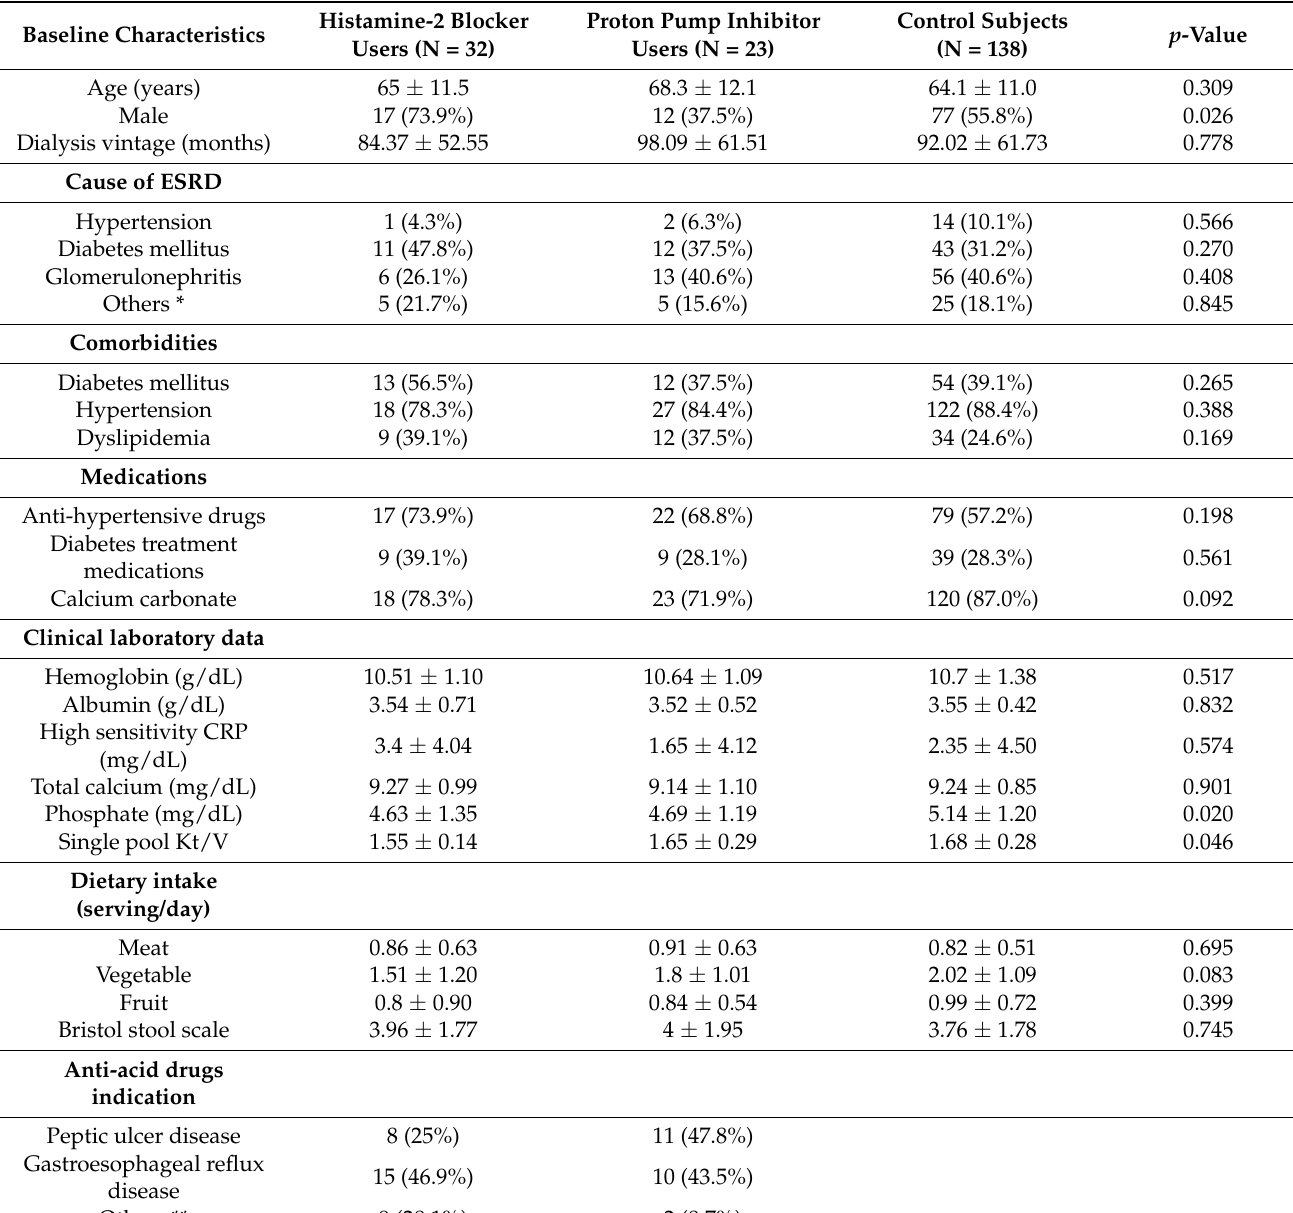
Table 1. Baseline characteristics of hemodialysis patients using the histamine-2 blocker (H 2 -blocker), proton pump inhibitor and the